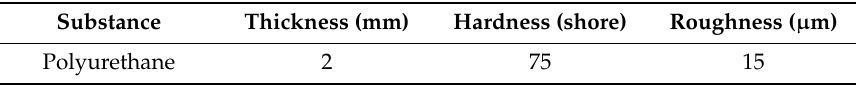
Table 2. Parameters of the polishing pad. Figure 13. Measurement point position on the sapphire substrate.